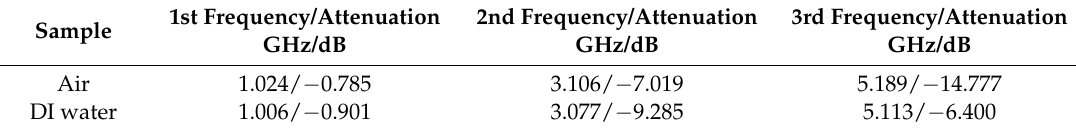
Figure 3. ( a ) Simulated response of the sensor; ( b ) simulation model showing strong electric field coupling on the interdigitated electrode (IDE) area, PDMS top layer is not shown here. Table 1. Corresponding frequencies in the simulation model.